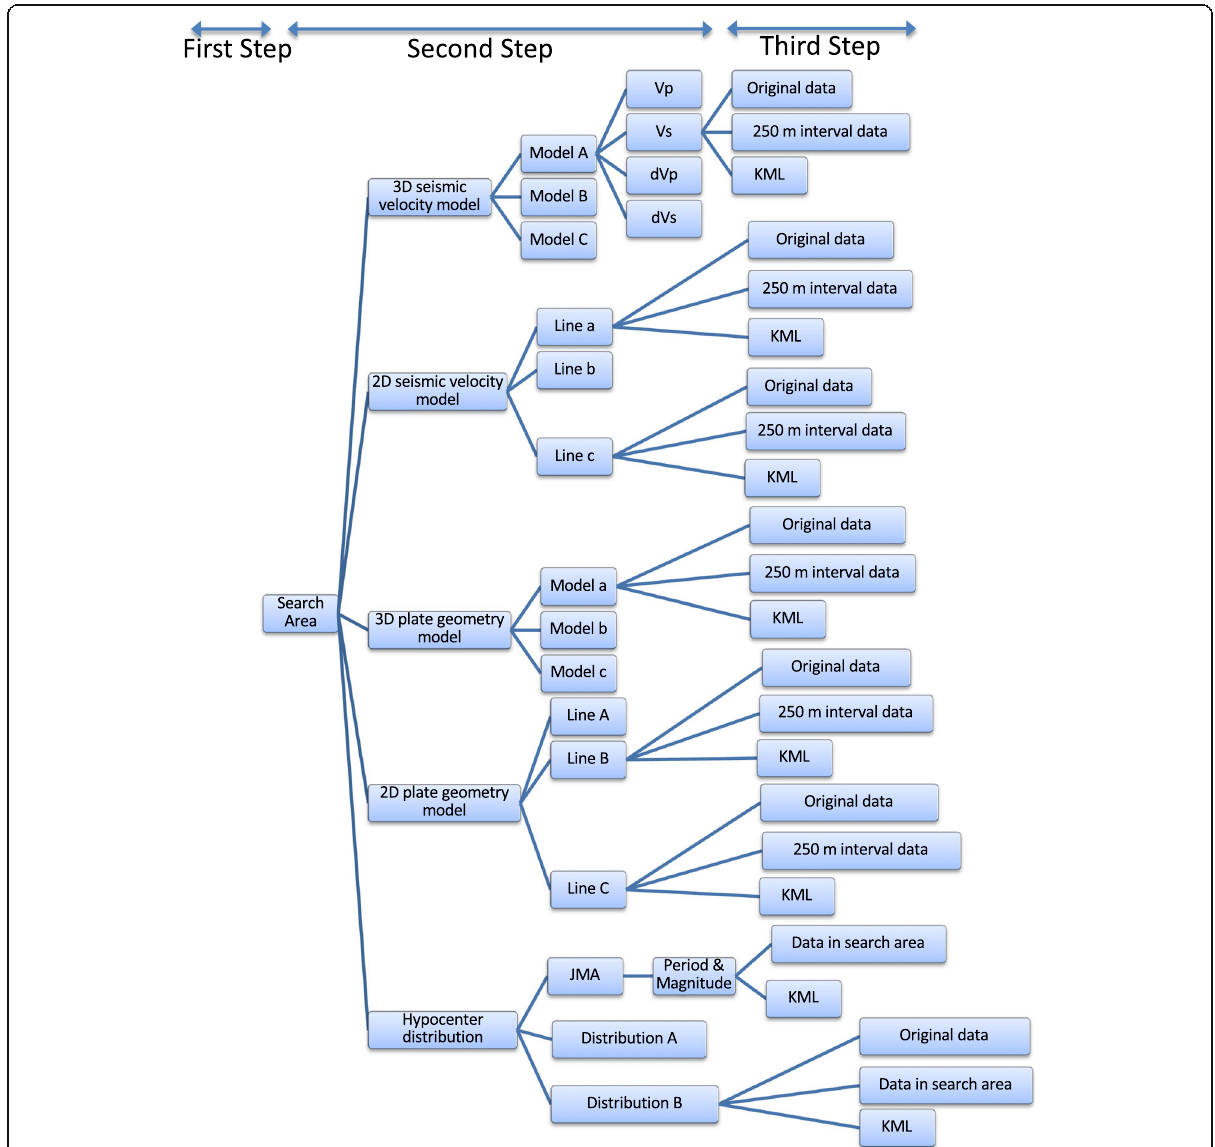
Fig. 1 Flowchart of the database search parameters. This search structure consists of three steps: definition of the search area, model selection, and selection of data for download. Once users set a search area, all models containing data within that search area are selected, regardless of model type. Each selection step is described in detail in the